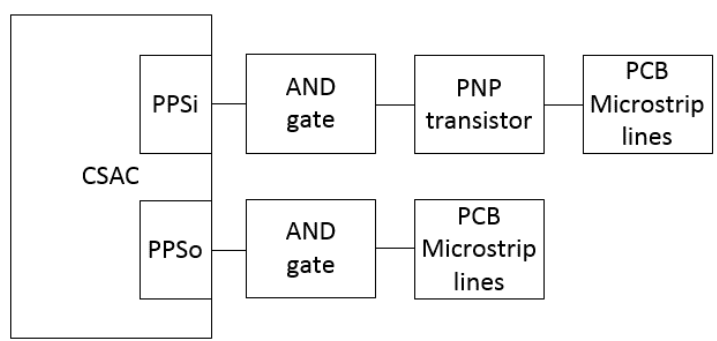
Figure 5. PPSi and PPSo blocks diagram representing the main delays sources on the CSAC PCB.